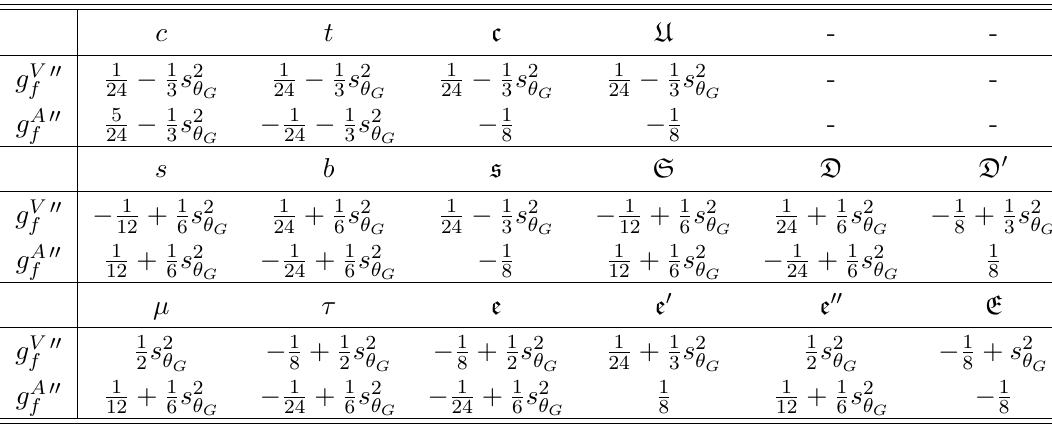
Table 10 . The couplings of the flavor-conserving neutral currents mediated by Z 00 basis, with θ being the SU(4) U(1) mixing angle defined in eq. (5.4). G W ⊗ X 0 context never involve two different flavors of SM fermions. Instead, they only involve one SM flavor with another heavy vectorlike fermion with the same electric charge, as will be explicitly given in eqs. (7.18b) and (7.20b). Below, we organize the relevant